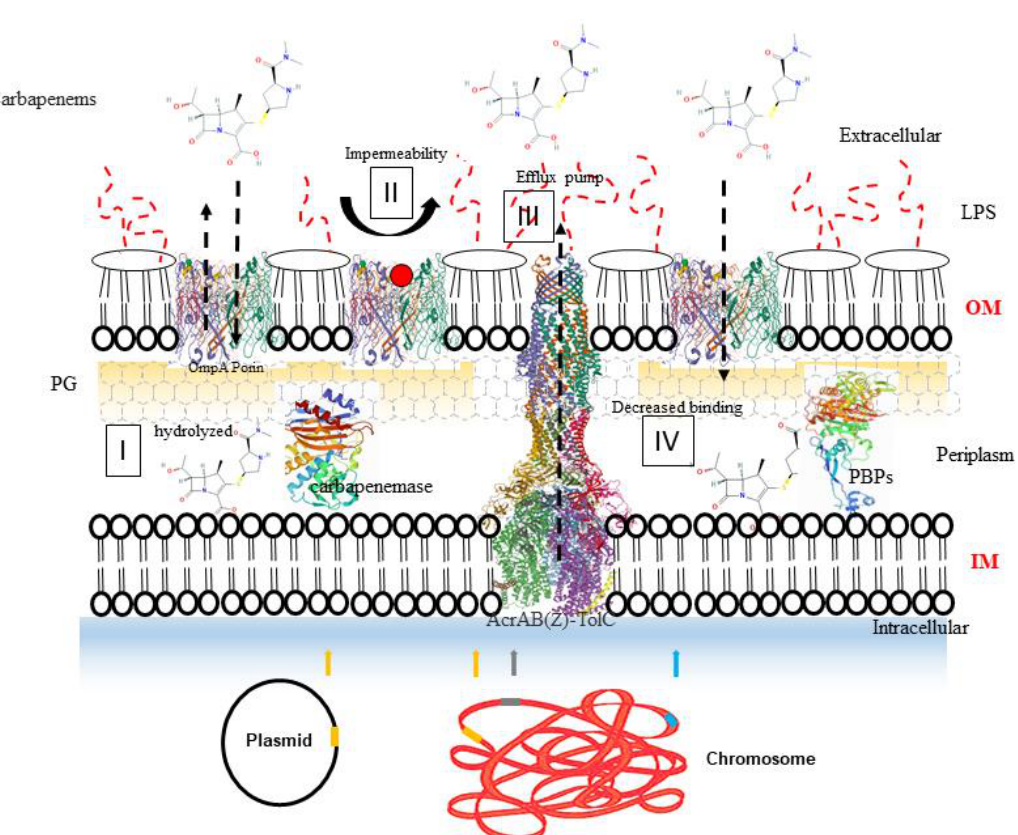
Figure 3. Major mechanisms associated with carbapenem-resistance in Gram-negative bacteria. (I) Production of carbapenemases enzyme from gene located on chromosome or plasmid that hydrolyze carbapenem antibiotics shown in golden rectangles. (II) Decreased permeability of the outer membrane due to structural mutations in porins (modified porins shown as red circle). (III) Drug efflux pumps. The blue and grey rectangles represent the chromosomal loci that encode various membrane associated proteins. Abbreviations: LPS, lipopolysaccharides; OM, outer membrane; IM, inner membrane; PG, peptidoglycan.